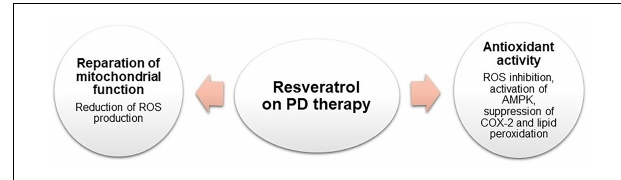
FIGURE 4 | Schematic representation of RES pharmacological activities on PD therapy.